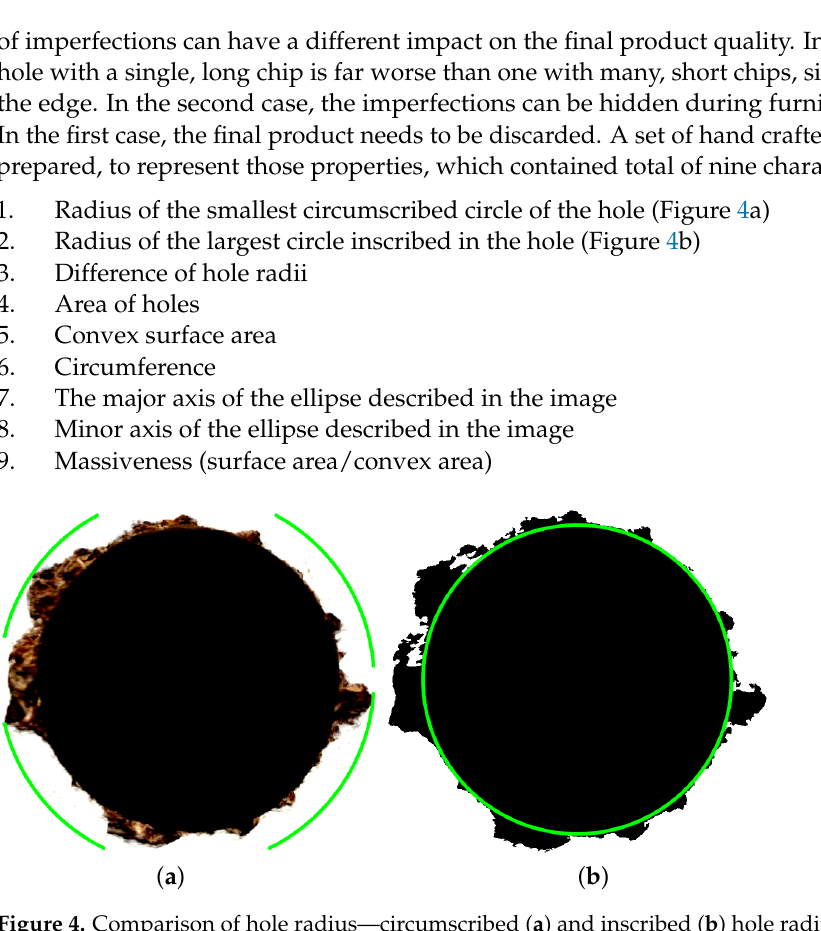
Figure 4. Comparison of hole radius—circumscribed ( a ) and inscribed ( b ) hole